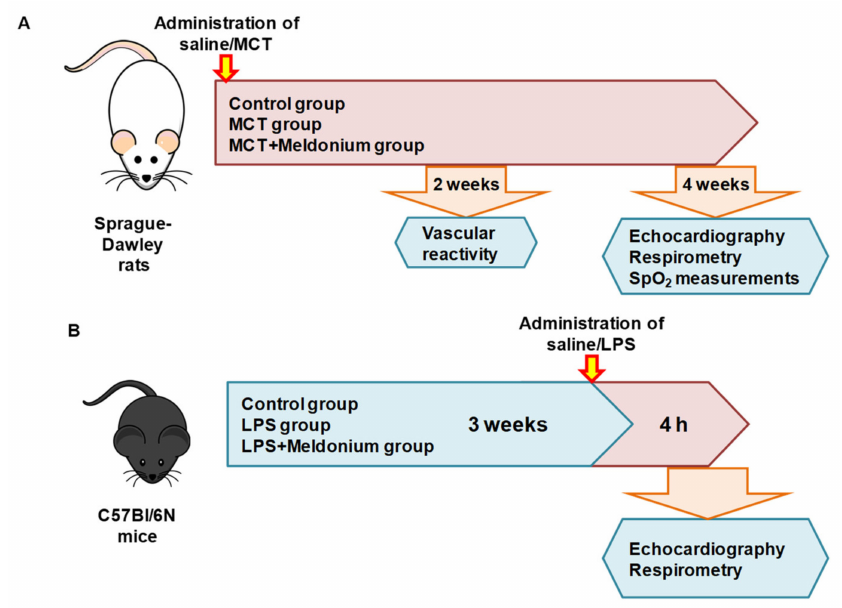
Figure 7. Schematic representation of the study design. MCT, monocrotaline; LPS,